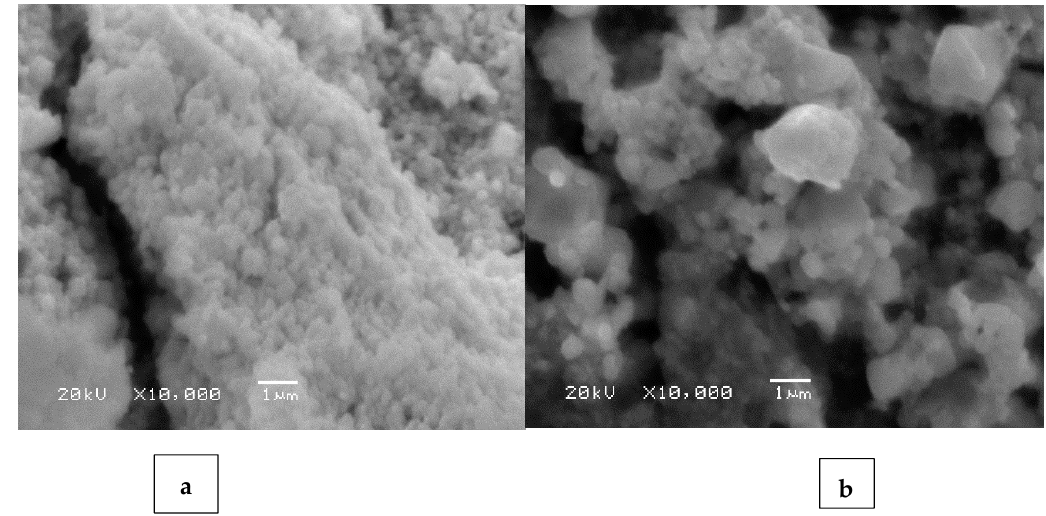
Figure 5. SEM images of AgNPs (0.2 g) before ( a ) and after Cu 2+ (10 mg/L) was adsorbed ( b ) for 3 h at 298 K.